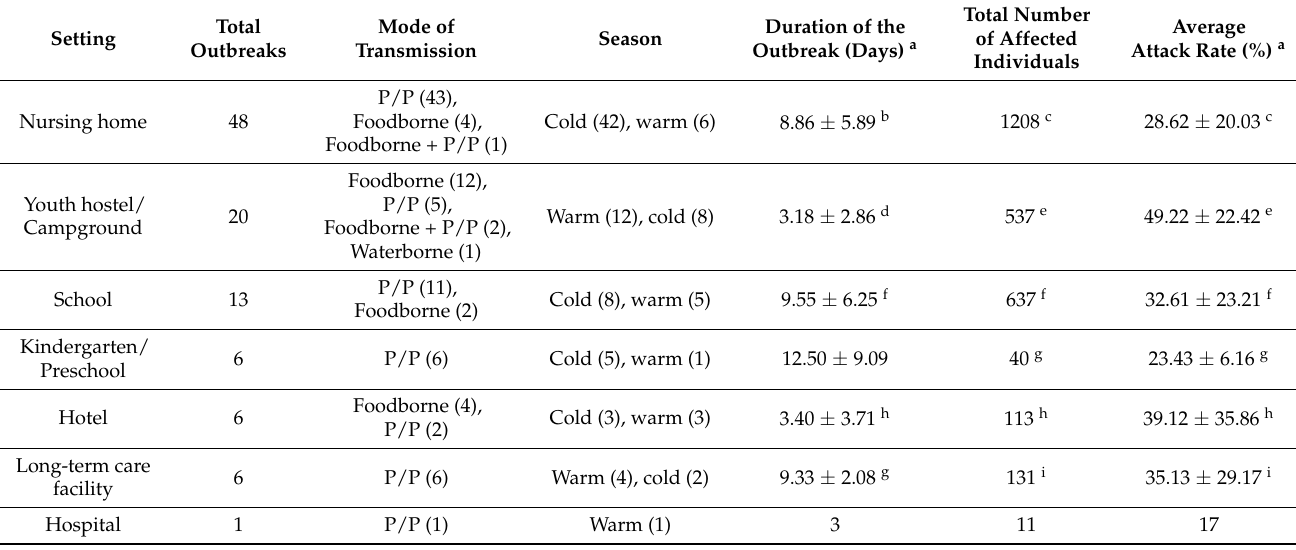
Table 2. Main epidemiological features of outbreaks included in the study, by